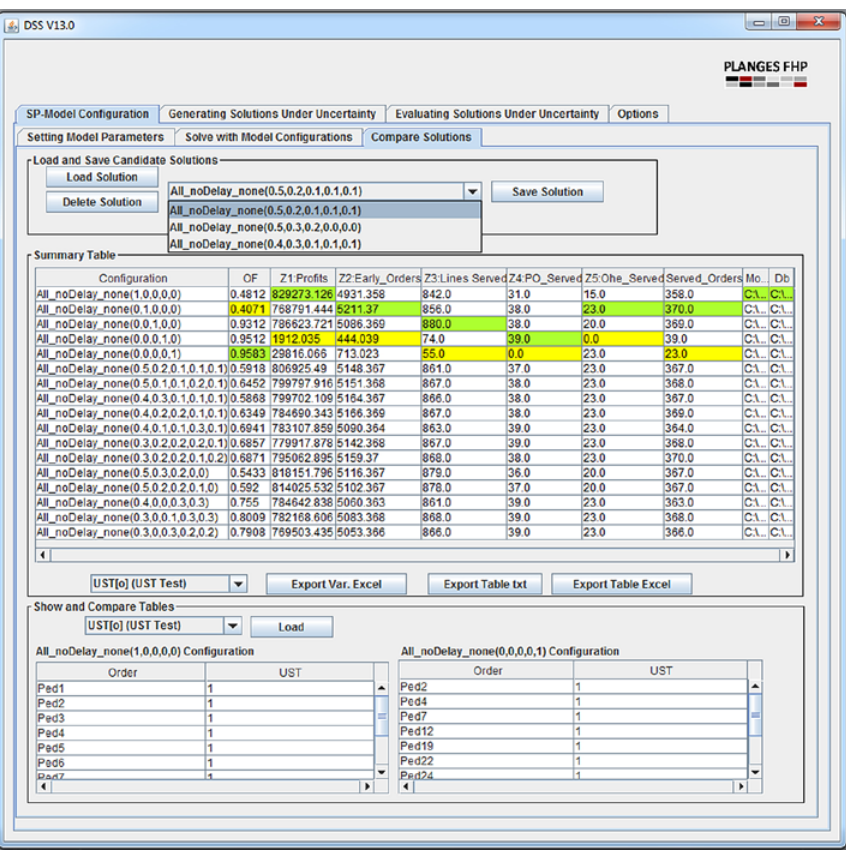
Fig. 4. The “Compare Solutions” screen of the